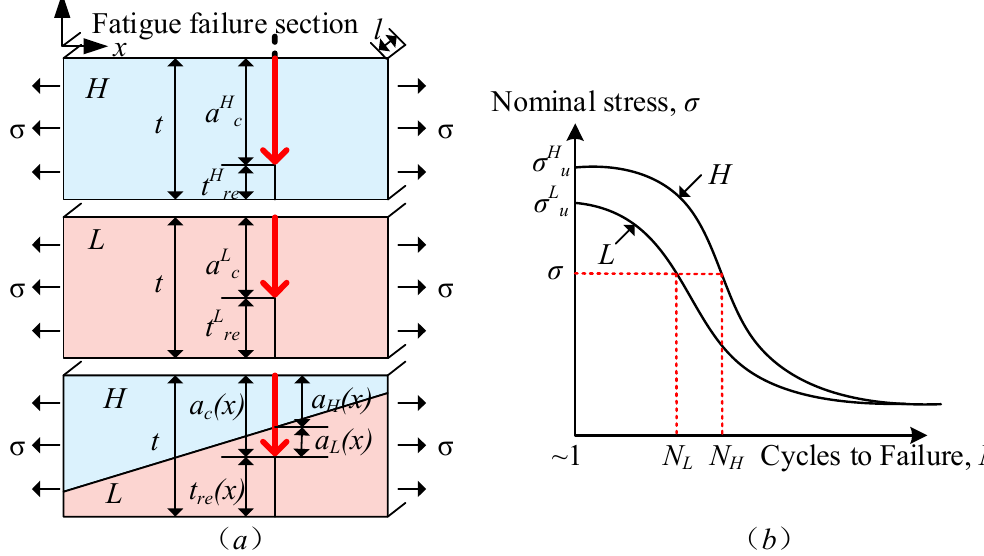
Figure 2. ( a ) Comparison of fatigue failure process between homogeneous and heterogeneous materials; ( b ) Mechanical properties of L and H.